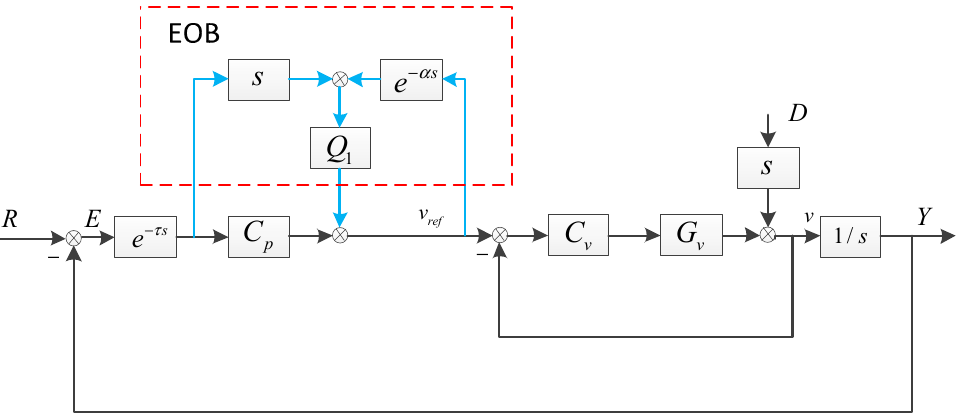
Figure 4. The EOB structure based on VDPC. e − as refers to an artificially added delay and α = τ . Q 1 refers to the EOB controller. Electronics 2018 , 7 , x FOR PEER REVIEW